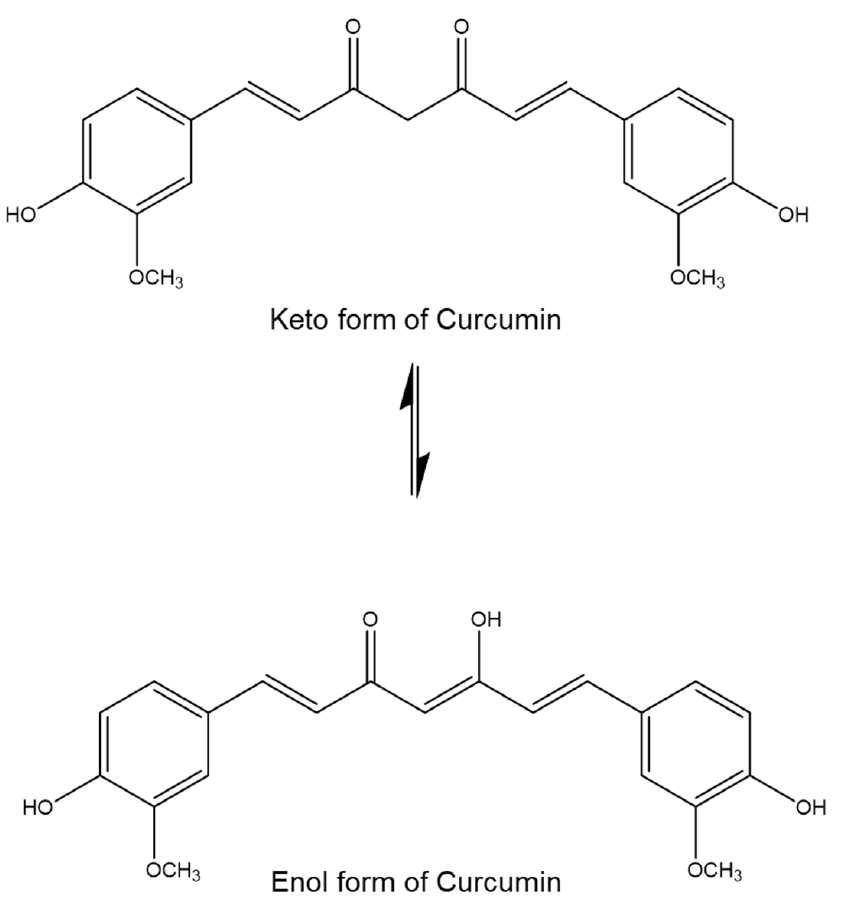
Figure 1. Chemical structure of curcumin.